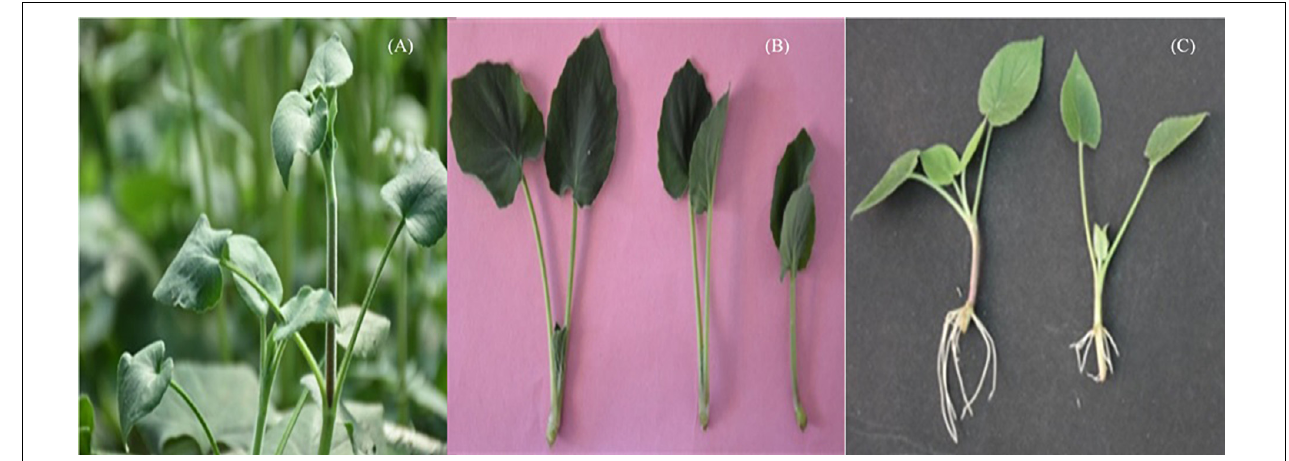
FIGURE 1 | Apical buds of Valeriana jatamansi (A) , single-node cuttings (B) , and root formation in cuttings (C) , treated with NAA 50 ppm (left) and control (right).